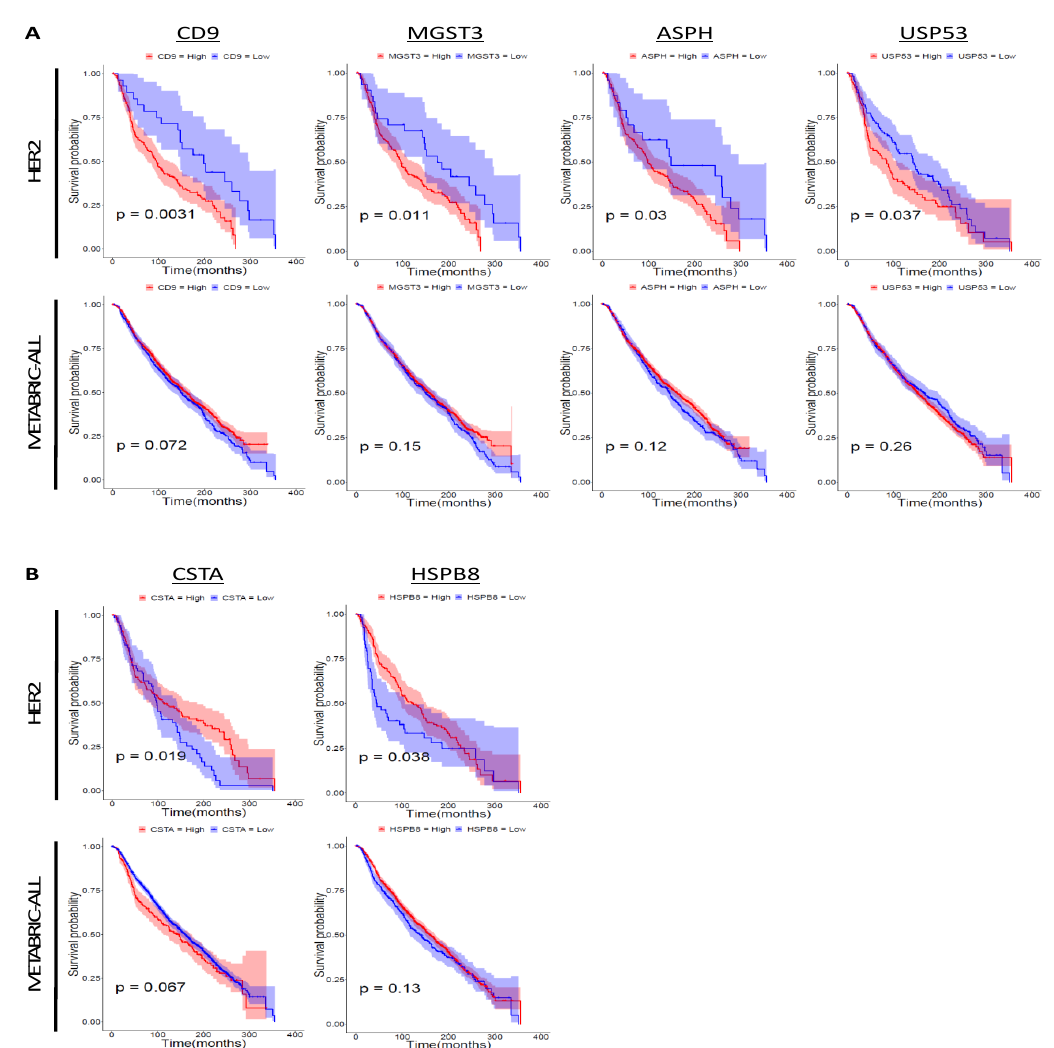
Figure 5. Survival analysis of signature genes upregulated in the RG. Survival analysis was conducted using the METABRIC dataset. The colored region along the curve shows the 95% confidential interval. Nine upregulated genes ( kynurenine 3-monooxygenase ( KMO ), inhibin subunit beta B ( INHBB ), zinc finger protein 663, pseudogene ( ZNF663P ), egl-9 family hypoxia-inducible factor 3 ( EGLN3 ), transmembrane protein 45B ( TMEM45B ), MAGE family member F1 ( MAGEF1 ), COMM domain containing 2 ( COMMD2 ), ZNF205 antisense RNA 1 ( ZNF205-AS1 ), and multiple EGF like domains 6 ( MEGF6 )) and four downregulated genes ( DNAJC25-GNG10 readthrough ( DNAJC25-GNG10 ), intraflagellar transport 57 ( IFT57 ), MYB proto-oncogene like 1 ( MYBL1 ), and adhesion molecule with Ig like domain 2 ( AMIGO2 )) were not analyzed because there were no data for these genes in the METABRIC dataset. ( A ) Survival analysis of signature genes upregulated in the RG. The number of specimens was as follows: METABRIC-ALL: CD9 (high = 1369, low = 535), MGST3 (high = 1423, low = 481), ASPH (high = 1432, low = 472), and USP53 (high = 1404, low = 500); HER2-positive: CD9 (high = 192, low = 28), MGST3 (high = 189, low = 31), ASPH (high = 196, low = 24), and USP53 (high = 113, low = 107). ( B ) Survival analysis of signature genes downregulated in the RG. The number of specimens was as follows: METABRIC-ALL: CSTA (high = 286, low = 1618) and HSPB8 (high = 1507, low = 397); HER2-positive: CSTA (high = 150, low = 70) and HSPB8 (high = 167, low = 53).